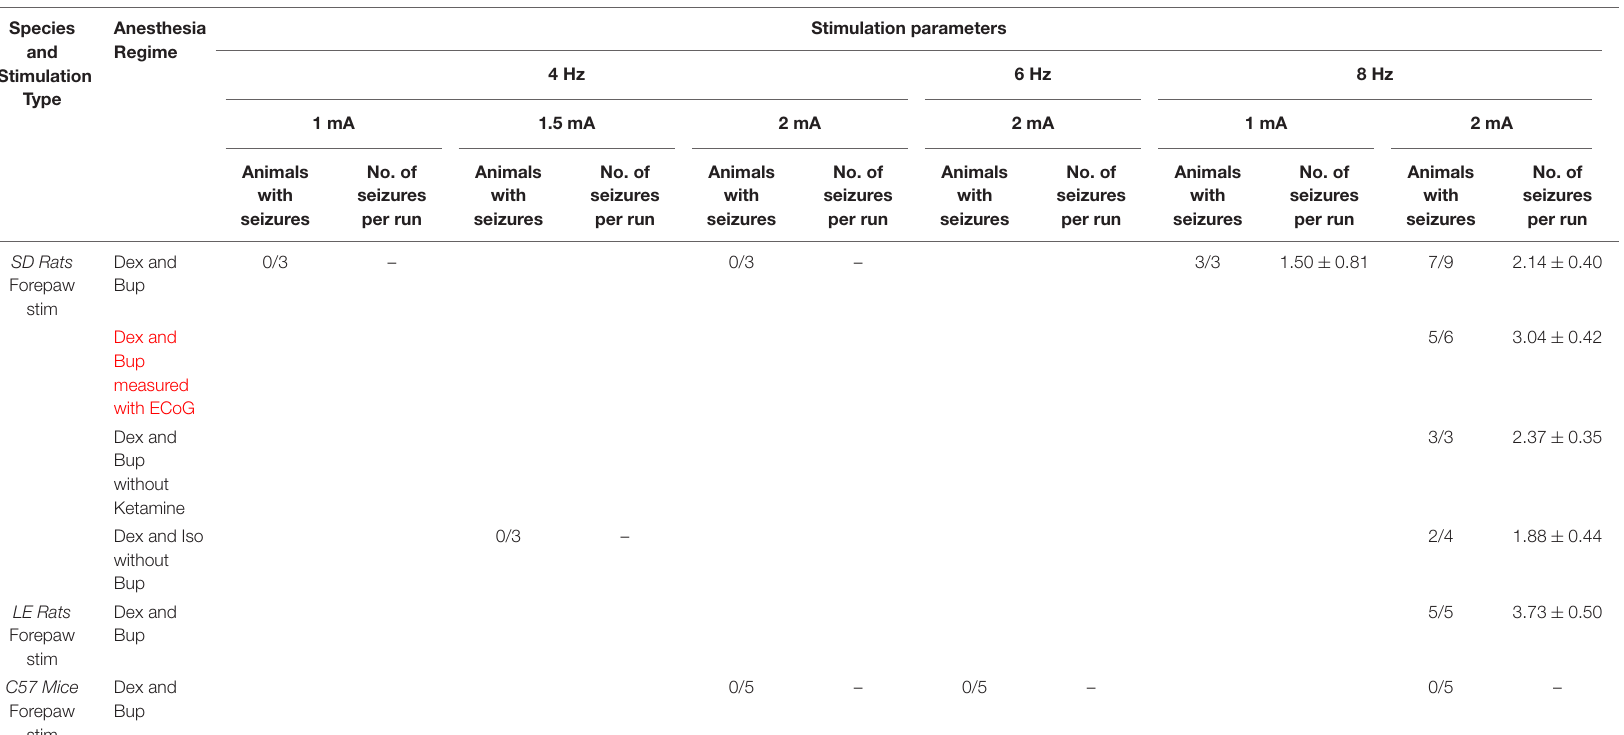
TABLE 1 | Average number of rats and mice with seizures and average number of seizures per run according to anesthesia regime and stimulation parameters. Species